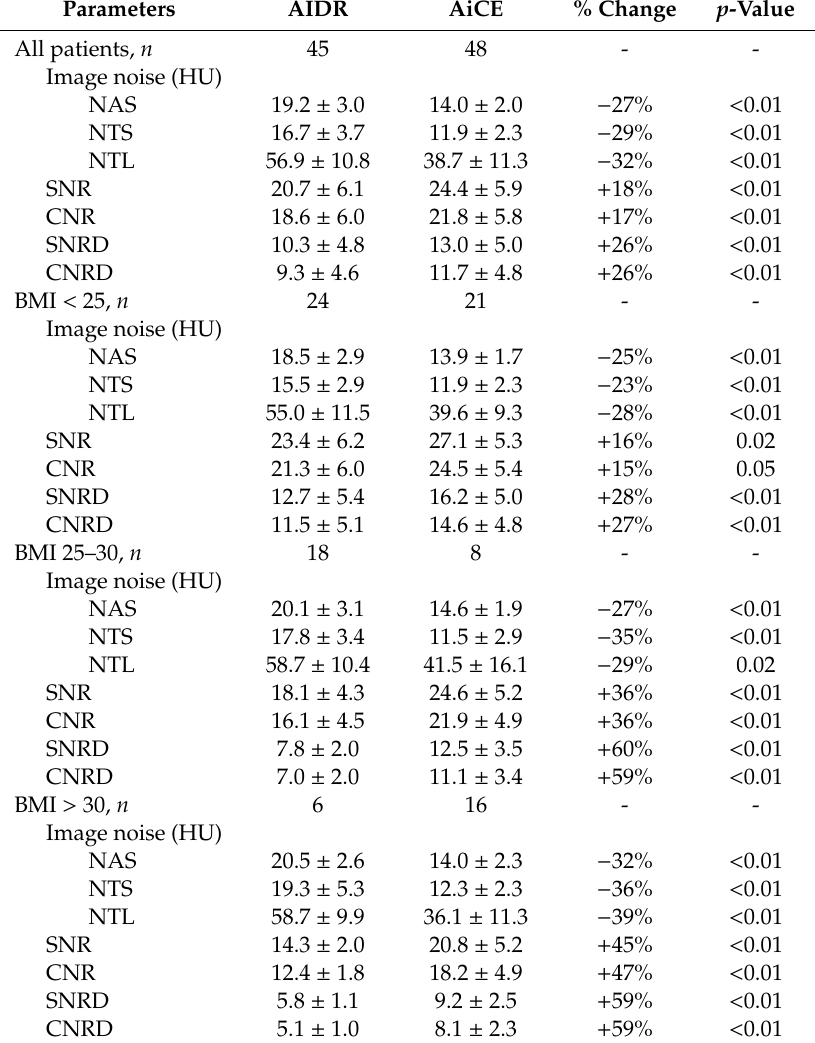
Table 2. Quantitative analysis of CT image quality for hybrid-IR (AIDR 3D) and DLR (AiCE). Parameters AIDR All patients,